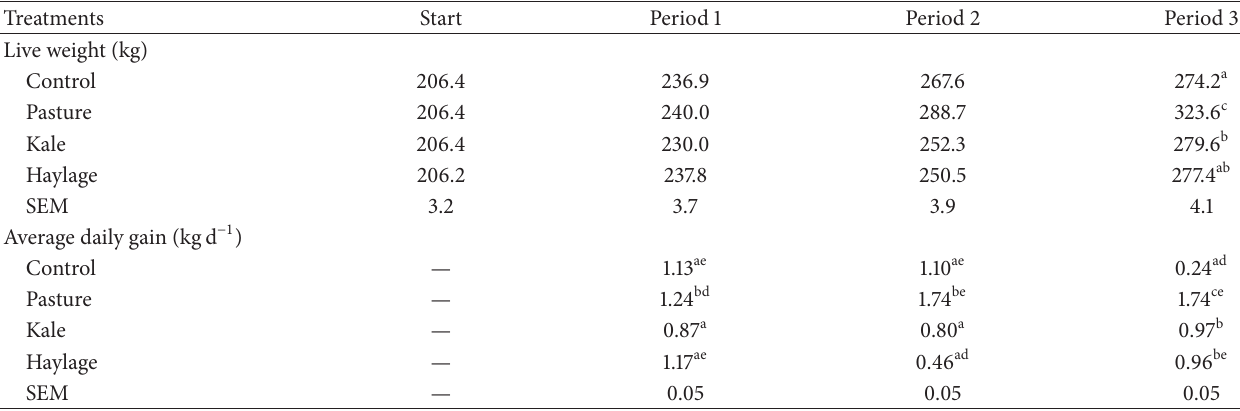
Table 1: Live weight and average daily gain of calves fed kale/haylage (Kale) ration compared to intensively managed pasture (Pasture),